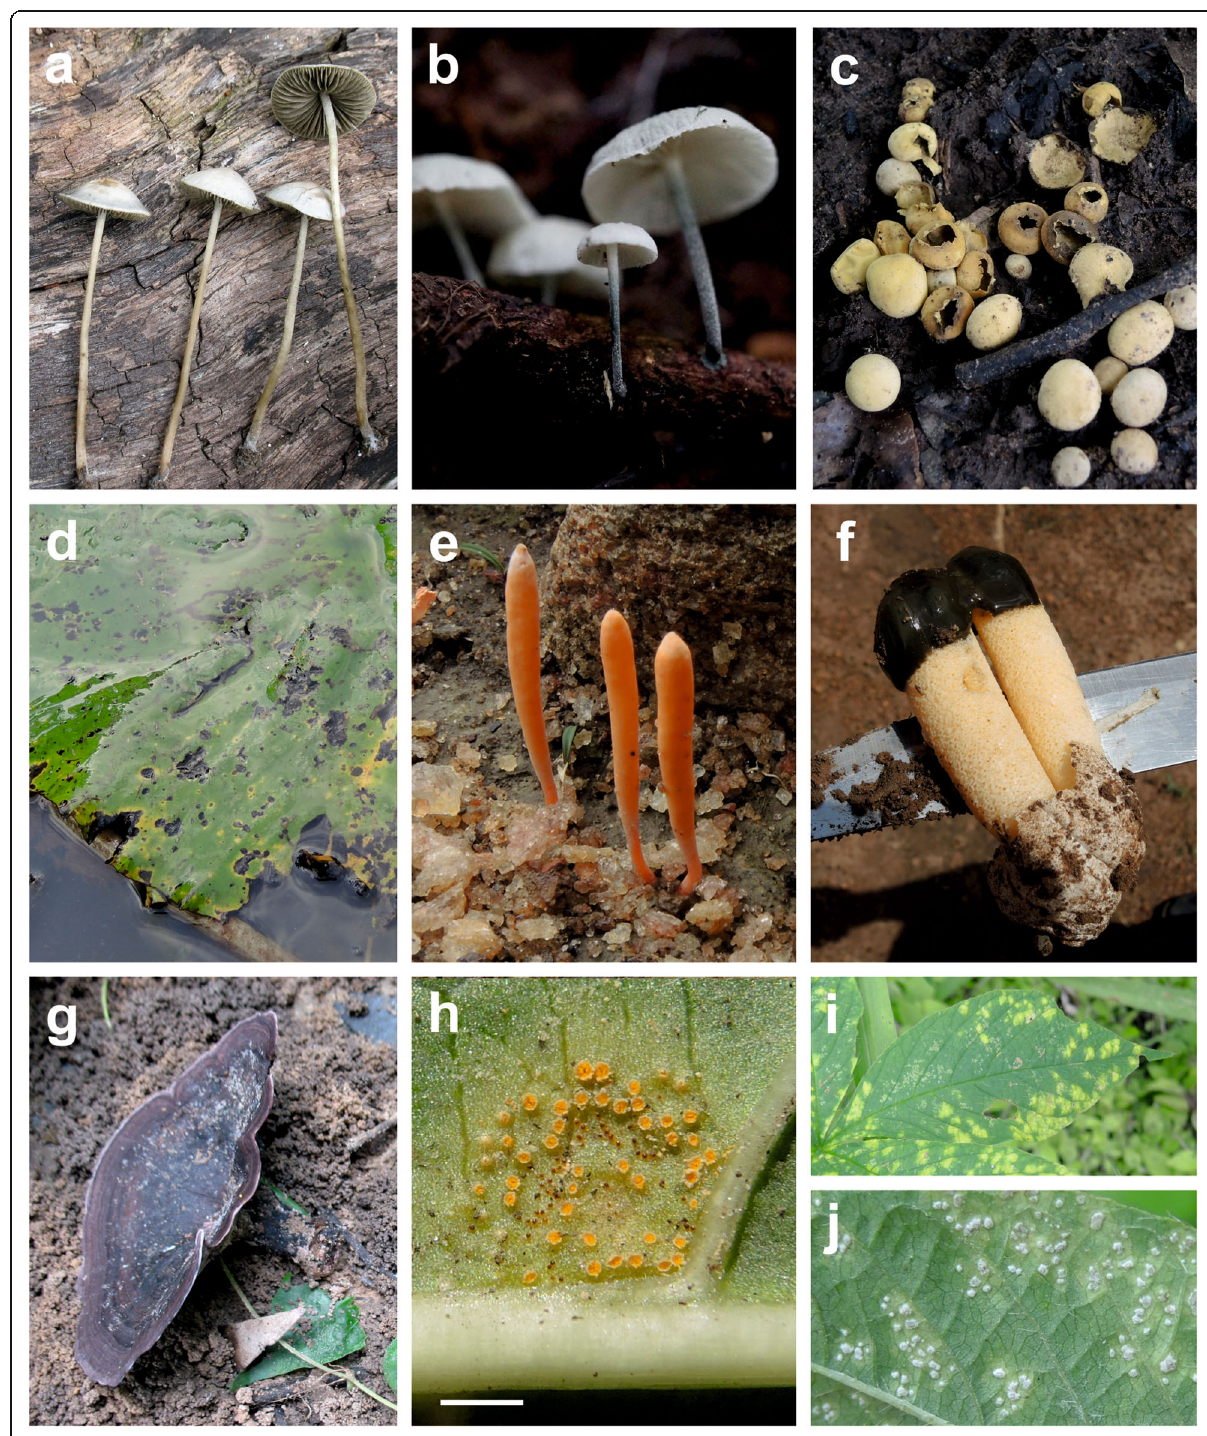
Fig. 6 Fungal species reported here for the first time for Benin. a Panaeolus bisporus (KaiR95). b Tetrapyrgos atrocyanea (KaiR783). c Scleroderma dictyosporum (B 06). d Rhamphospora nymphaeae on Nymphaea sp. (MP 5382). e Sulzbacheromyces miomboensis (Taneka 26.7.2017, no specimen). Note three clavarioid spore-producing bodies and a thin green lichen thallus covering the soil. f Phallus aurantiacus . g Nigroporus stipitatus (KaiR116). h The rust fungus Aecidium flavidum on the lower side of a leaf of Pavetta crassipes (B11). Note the presence of tiny brown spermatogonia surrounded by aecidia. Scale bar = 2 mm. i – j White rust fungus Albugo ipomoeae-panduratae on Merremia aegyptia (B 22). i Lesions evident on the upper side of a leaf. j White sori on the lower side of a